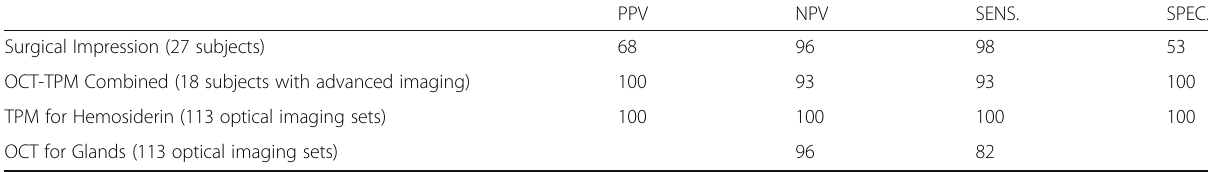
Table 1 Statistical results of surgical impression/ advance optical imaging vs histologic gold standard PPV NPV SENS.